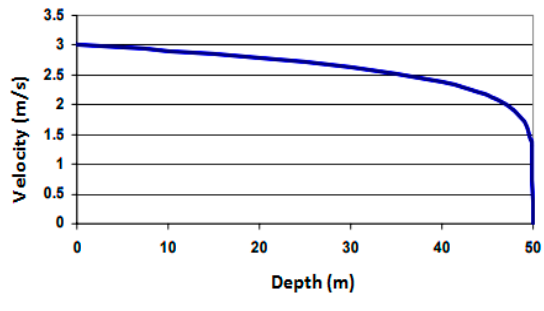
Figure 3. Water speed vs. depth.